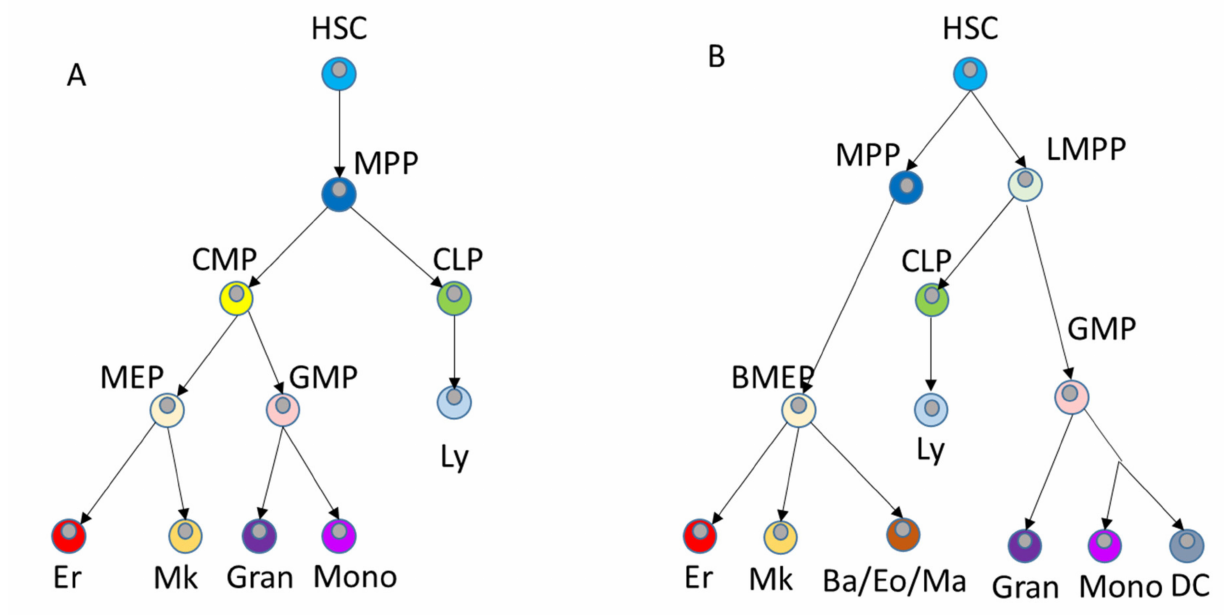
Figure 2. Hierarchical models of hematopoiesis: ( A ) 2006 model, adapted from [60]; ( B ) modern model of con- tinuous hematopoiesis, adapted from [59]. MPP—intermediate multipotent progenitors, CMP—common myeloid progenitors, CLP—common lymphoid progenitors, MEP—megakaryocyte/erytroid progenitors, GMP—granulocyte- macrophage progenitors, Er—erythrocytes, Mk—megakaryocytes, Gran—granulocytes, Mono—monocytes—macrophages, LMPP—lympho-myeloid polypotent progenitors, Ba—basophils, Eo—eosinophils, Ma—macrophages, Ly—lumphocytes, DC—dendritic